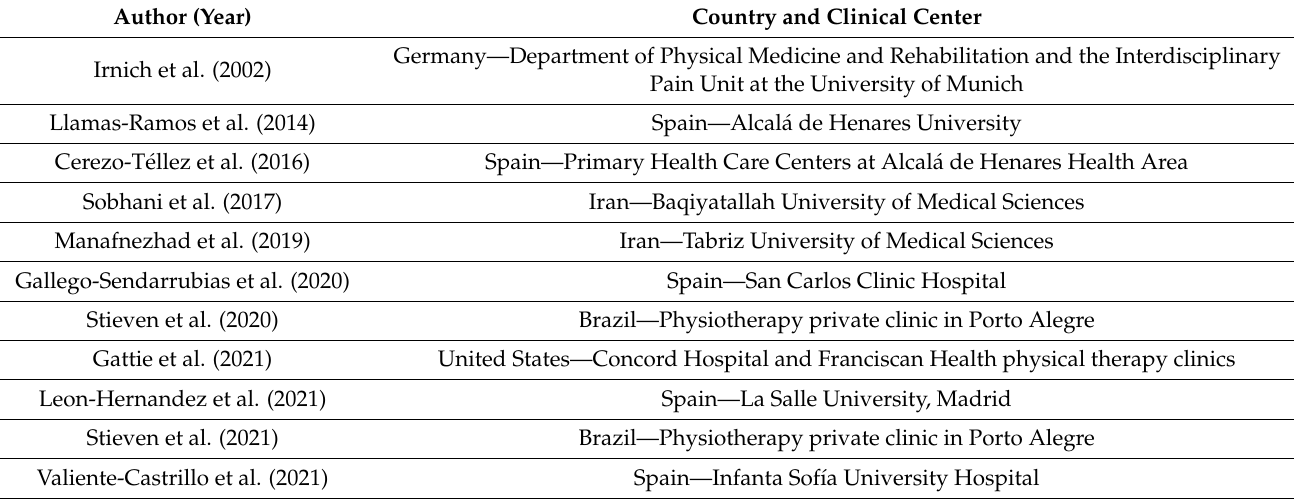
Table A2. Specific details of